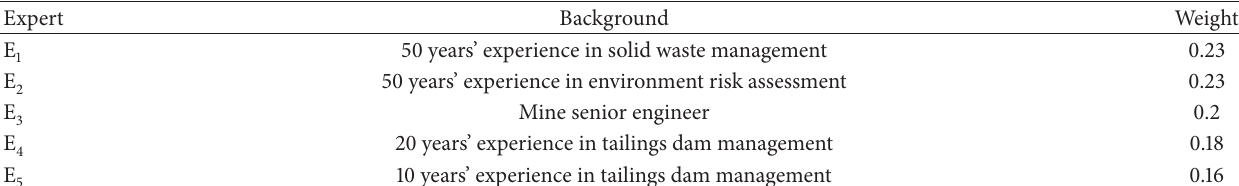
Table 5: The scale of weight for